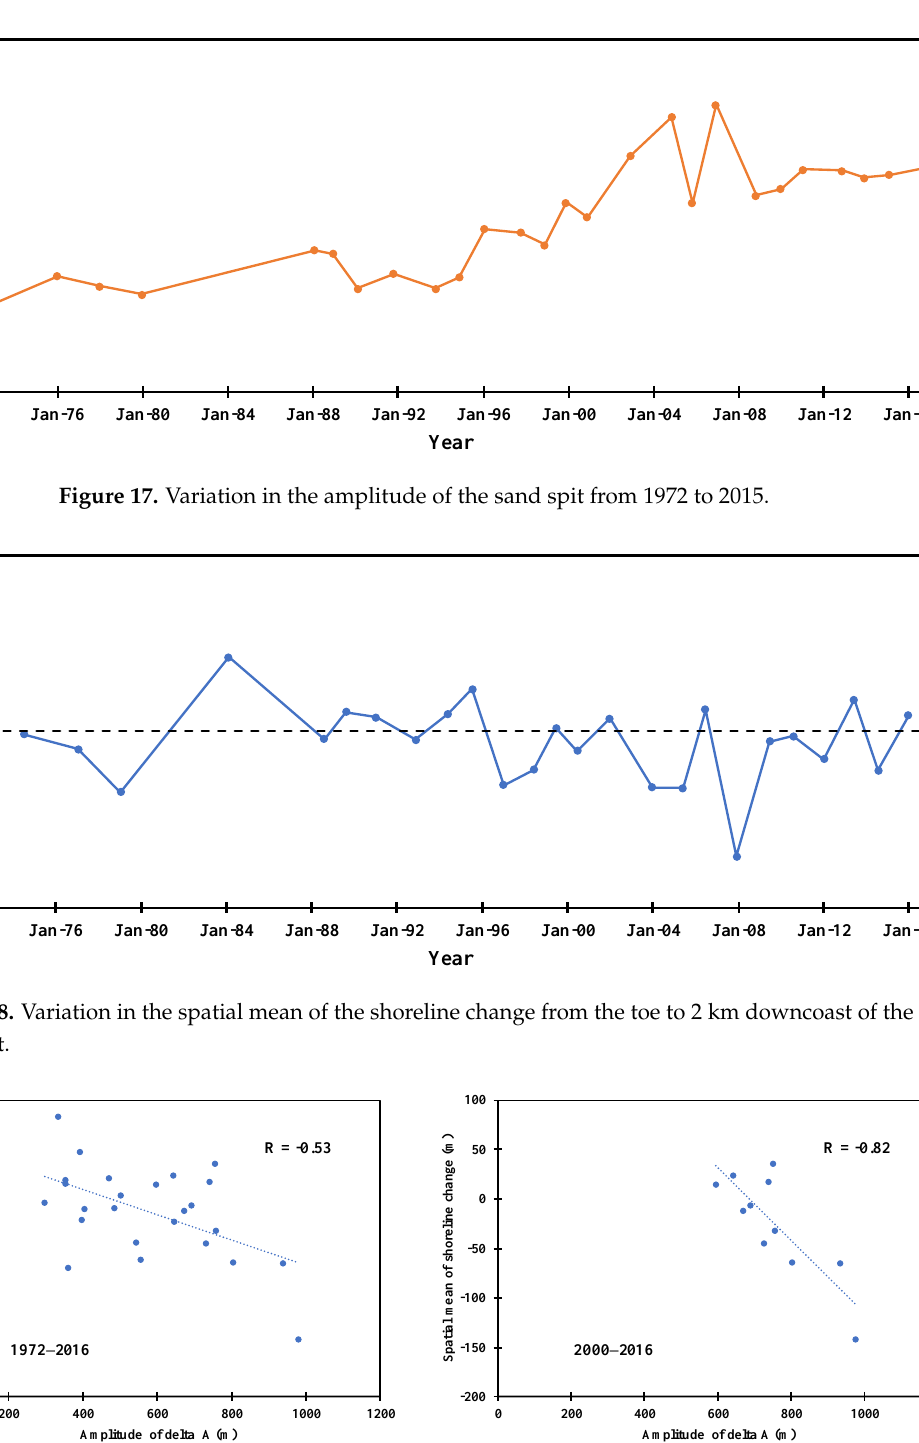
Figure 19. Scatter plot between the amplitude of sand spit A and the spatial mean of shoreline change from 1972–2016 ( left ) and 2000–2016 ( right ).